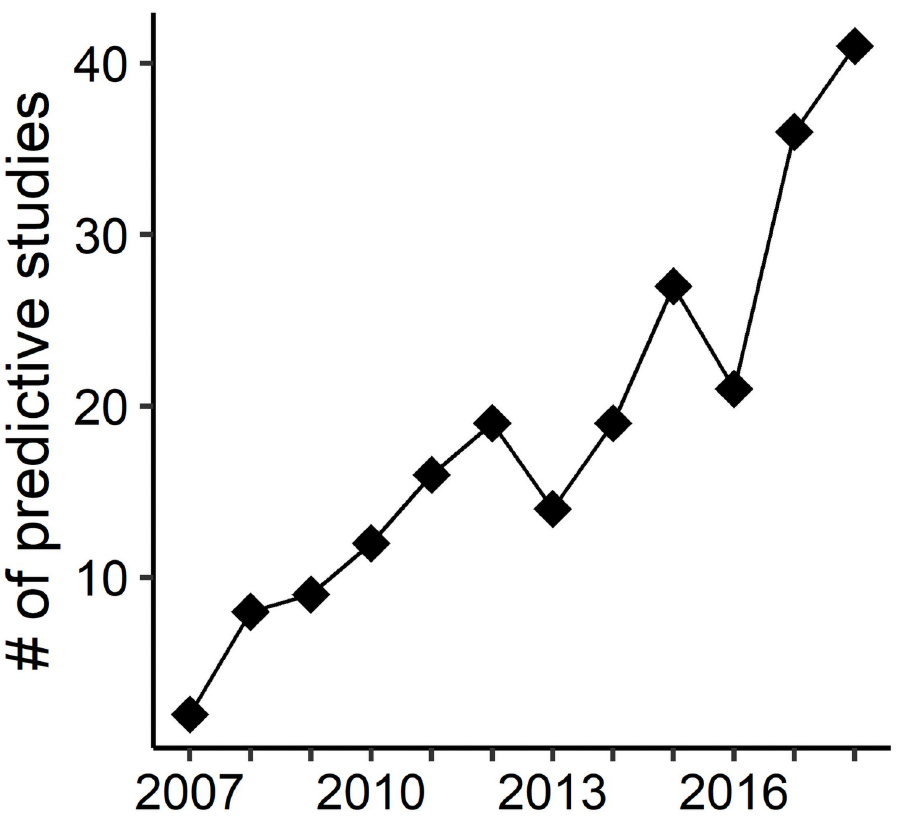
Fig 1. Temporal trend in marine fish predictive modeling studies. Number of published articles from 2007–2018 that predicted the spatial distribution of marine fish based on a search conducted in the Web of Science database.